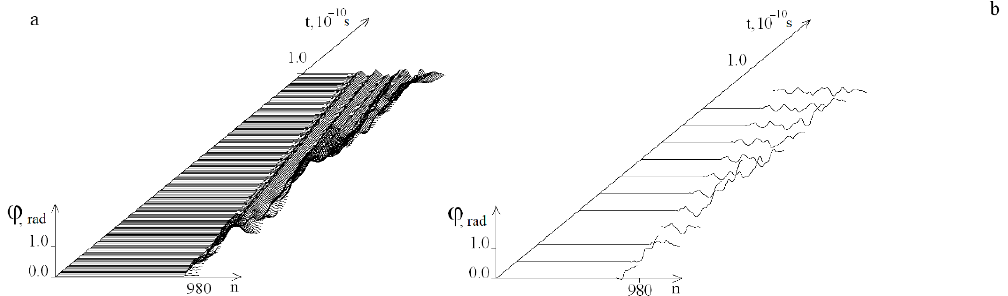
Figure 12. Graphs of the angular deviations of the DNA molecule first chain under the localized torque action on the interval [881, 980] at M 0 = 14.032 on the time interval [0, T 0 ]. ( a ) shows 200 graphs and ( b ) has 12 graphs.